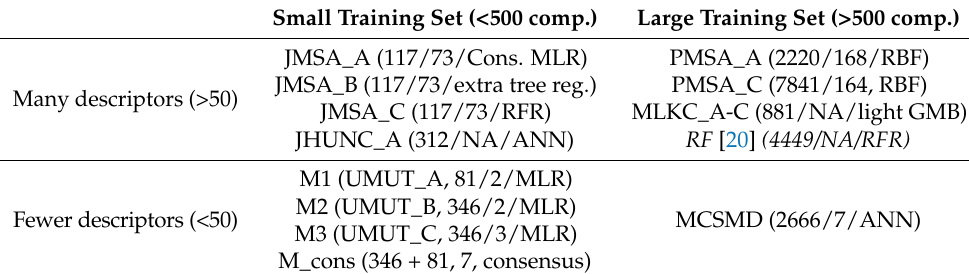
Table 4. Size of training sets and number of descriptors in the top SC2019 models * # . Small Training Set (<500 comp.) Large Training Set (>500 comp.)